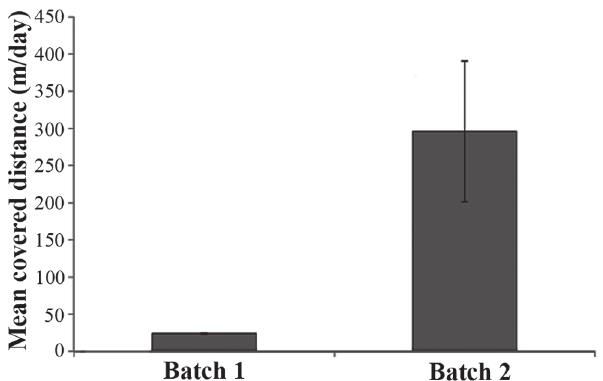
Fig. 3 . Mean covered distance per day of batch 1 (n = 27; x = 24.30m ± 0.65) and batch 2 (n = 29; = 296.34m ± 94.73) during the first ten days after